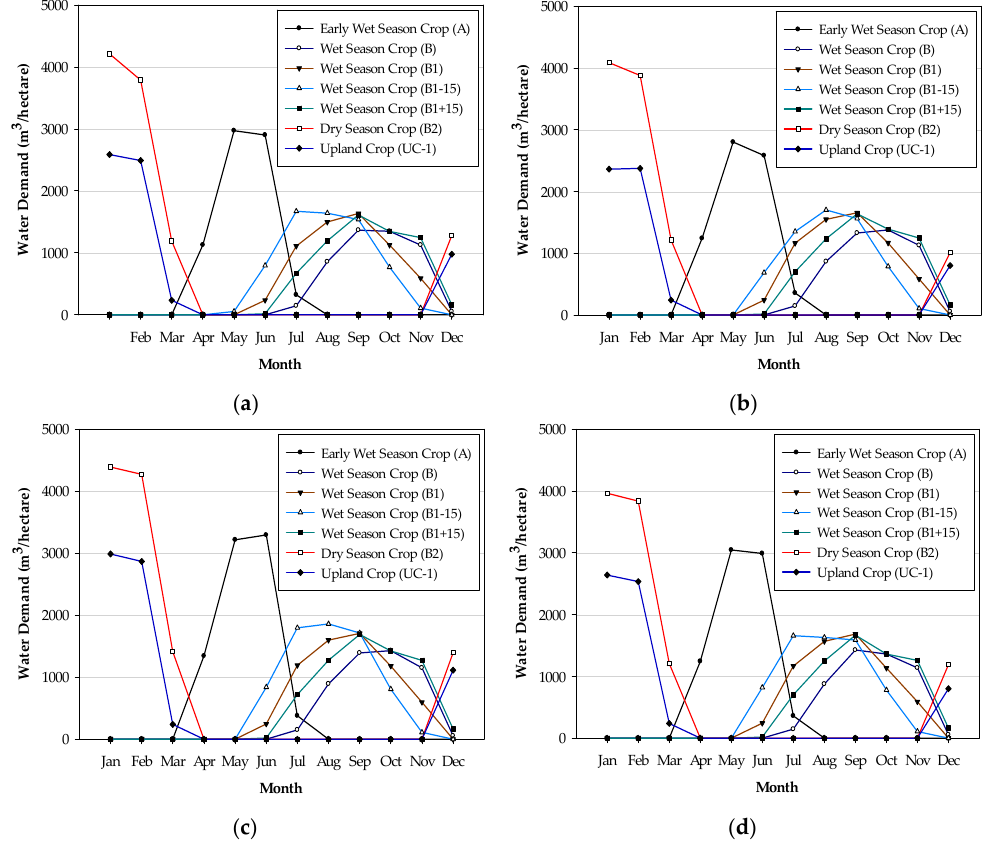
Figure 6. The unit of irrigation water requirement of each crop type: ( a ) Baseline, ( b ) GFDL-CM3